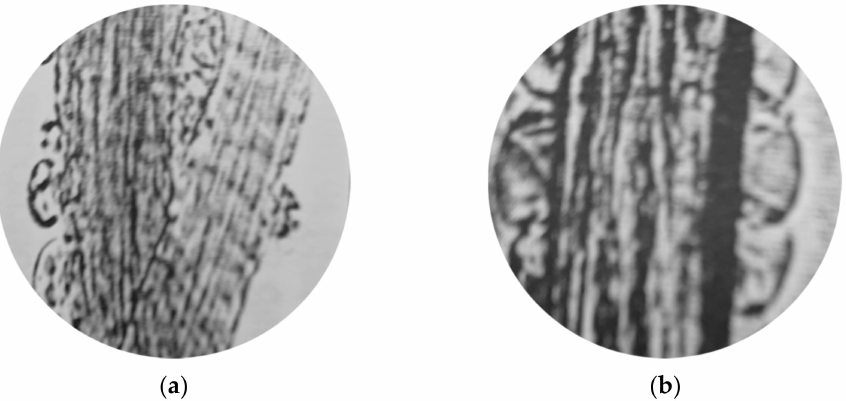
Figure 1. The swelling reaction of wool in ( a ) Krais–Markert–Viertel and ( b ) Allworden reagent. Fiber diameter, d ( µ m) was measured on 1000 fibers using Lanameter, Carl Zeiss-Jena, a special projection microscope for measuring the diameter of wool fibers [44].